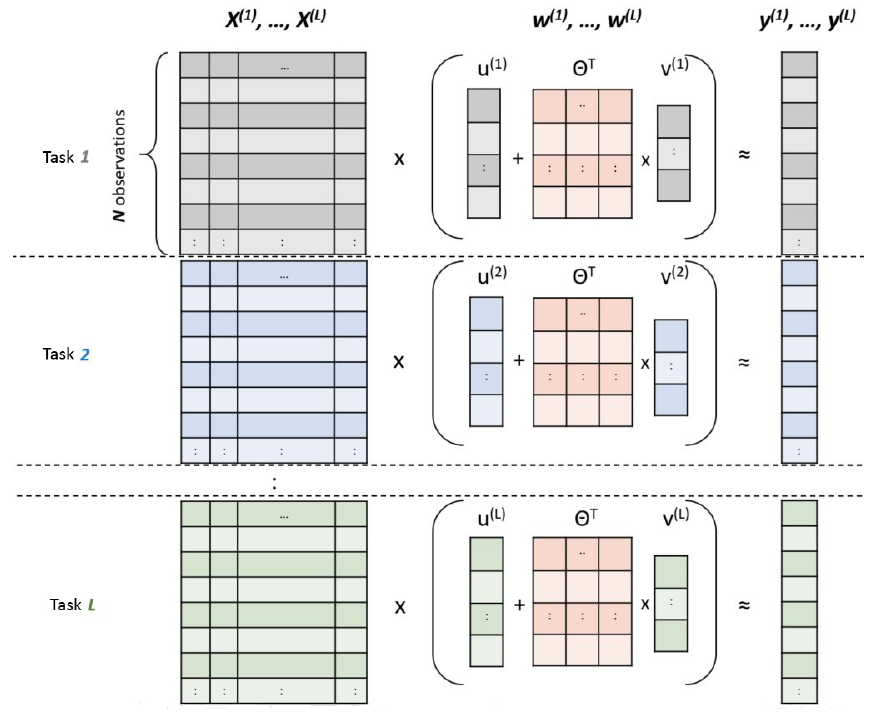
Figure 2. Graphical representation of the ASO method. The input of the method is the datasets X ( 1 ) , X ( 2 ) , ..., X (L) of all locations. The corresponding target vectors are denoted with y ( 1 ) , y ( 2 ) , ..., y (L) . The weight vector w (l) parts: to the weight vector u (l) dimensional feature map (cid:50) T